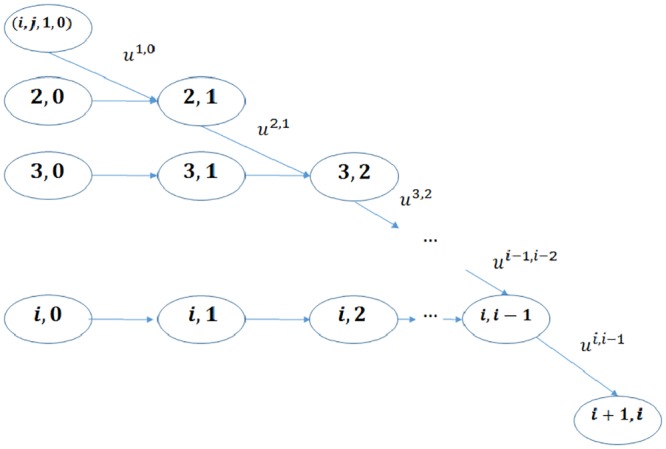
The state space for the same (i, j) pair, 0 ≤ i, 0 ≤ j and their transition relations.